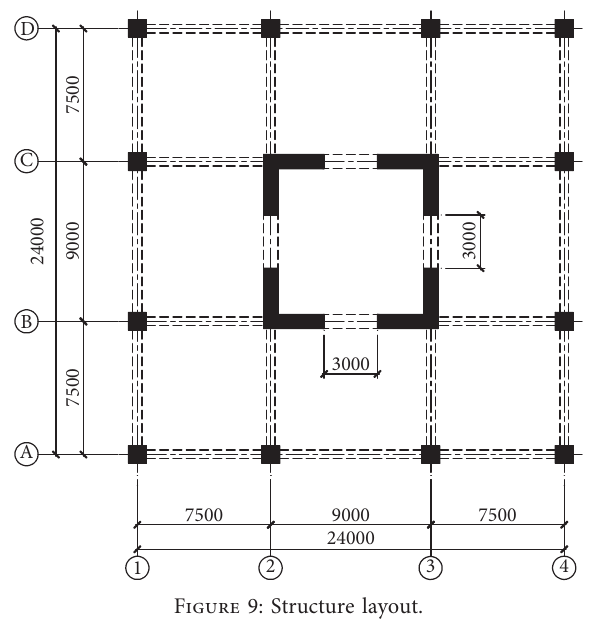
Figure 9: Structure